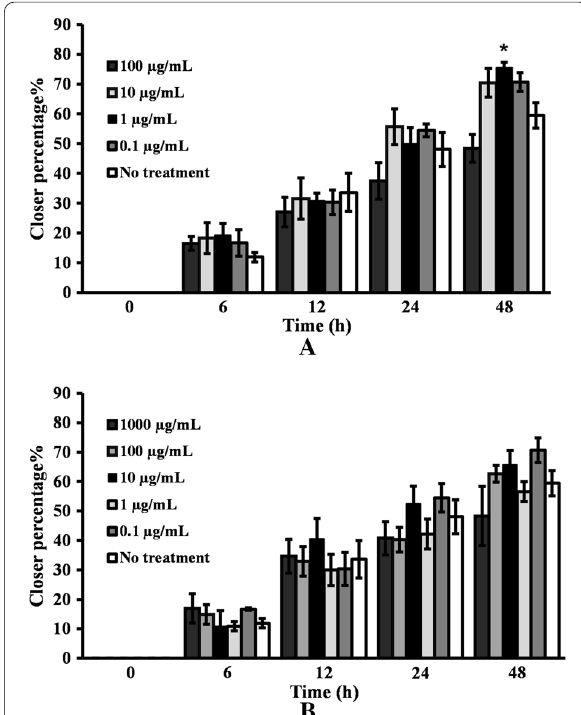
Fig. 4 Closure percentage of wound area with different concentrations of A. indica aerial parts ( A ) and root ( B ) extracts. Data represent mean SEM ( n 4). Statistical analysis was carried out ± = using one-way ANOVA followed by t test. *Statistically significant between extract concentrations vs. the untreated control in each time interval at * p <